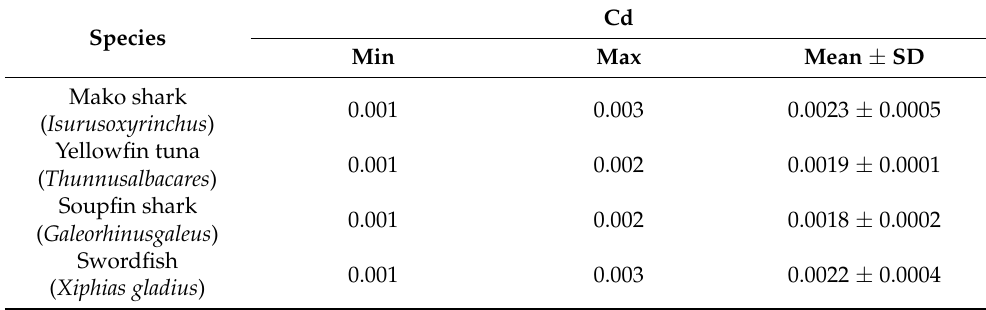
Table 4. Minimum, maximum, mean, and standard deviation (SD) of Cd in canned tuna samples